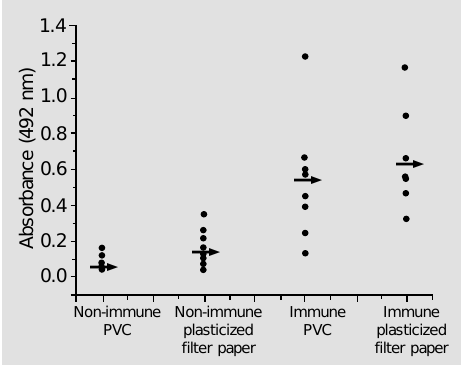
Figure 3 - Titration of serum from rabbits immunized or not against F1 antigen by ELISA using filter paper plasticized with polyvinyl alcohol-glutaraldehyde. Sera (100 µl) from immunized rabbit (circles), non-immunized rabbit (squares) and PBS (triangles) were diluted from 1:400 to 1:51,200 in PBS and ELISA was carried out according to the best conditions for antigen (1.25 µg/disc) and conjugate concentration (diluted 1:12,000). Insert , The ratio (factor F) between the absorbance values recorded for the immunized and non-immunized serum was calculated for each